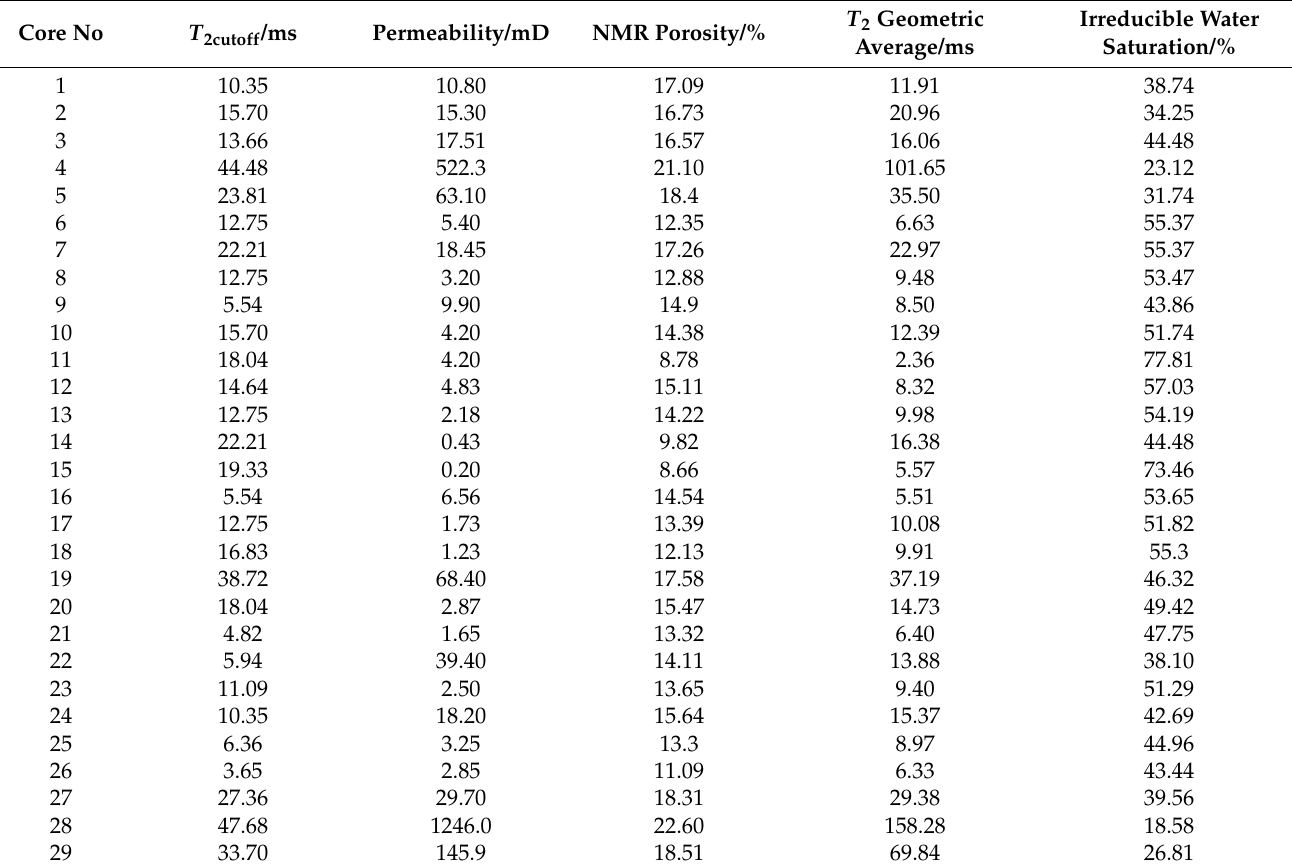
Table 2. Statistical table of physical property parameters of 29 sandstone core